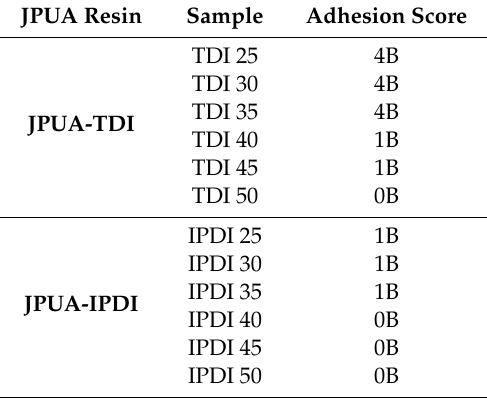
Table 6. Adhesion score of JPUA films.